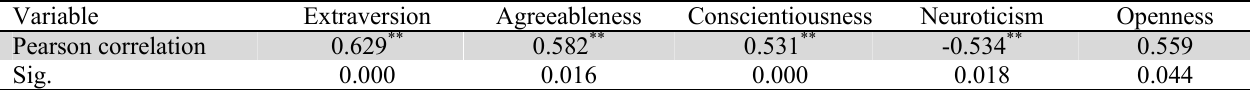
The summary of Pearson correlation test between emotional intelligence and personality traits Variable Extraversion Pearson correlation